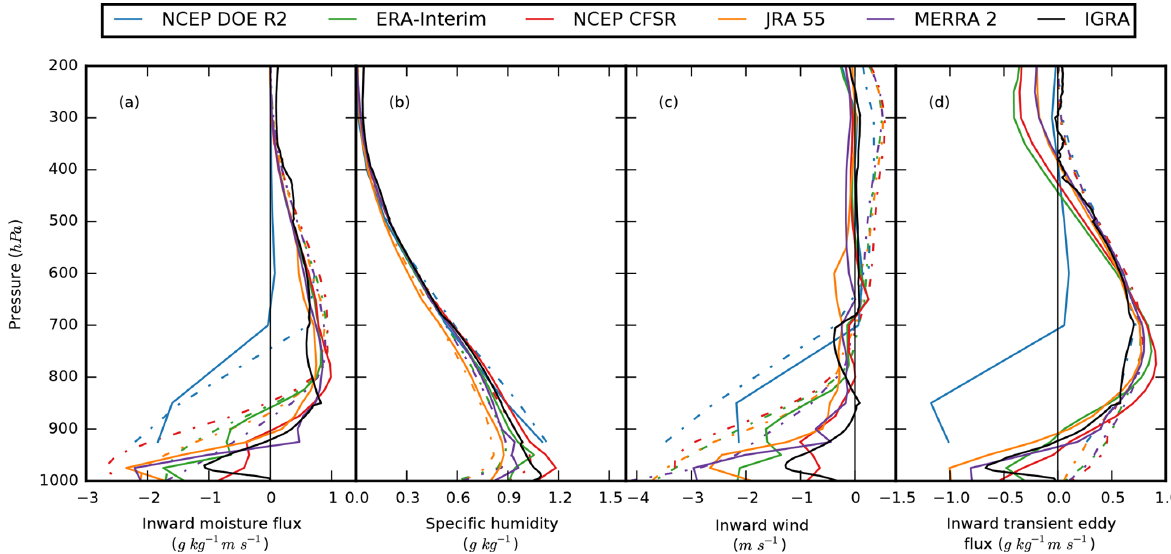
Figure 7. Mean vertical profiles over radiosonde sites, simultaneously with observations (solid lines); along the coast of the East Antarctic ice sheet for the whole 1980–2016 period (dashed lines). The variables displayed in the panels are moisture flux (a) , specific humidity (b) , mean wind (c) and transient eddy fluxes (d)